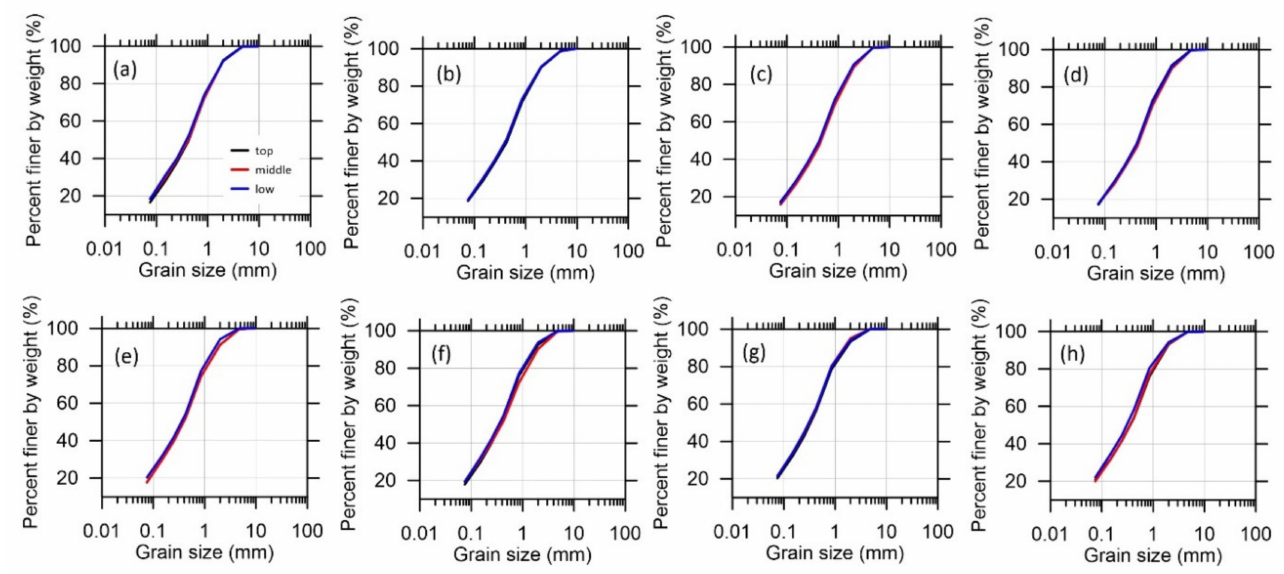
Figure 6. Grain size distribution obtained from the top, middle, and lower parts of the ring shear cylinder after shearing. The order is the same as shown in Figure 5.